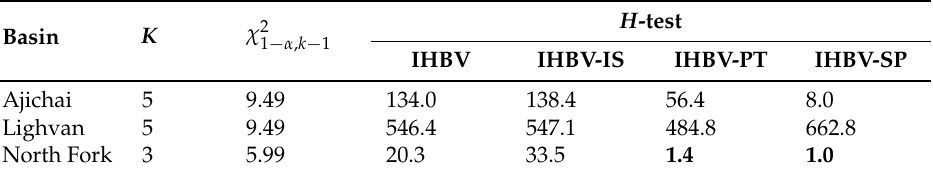
Table 6. The value of H-test for residuals of the